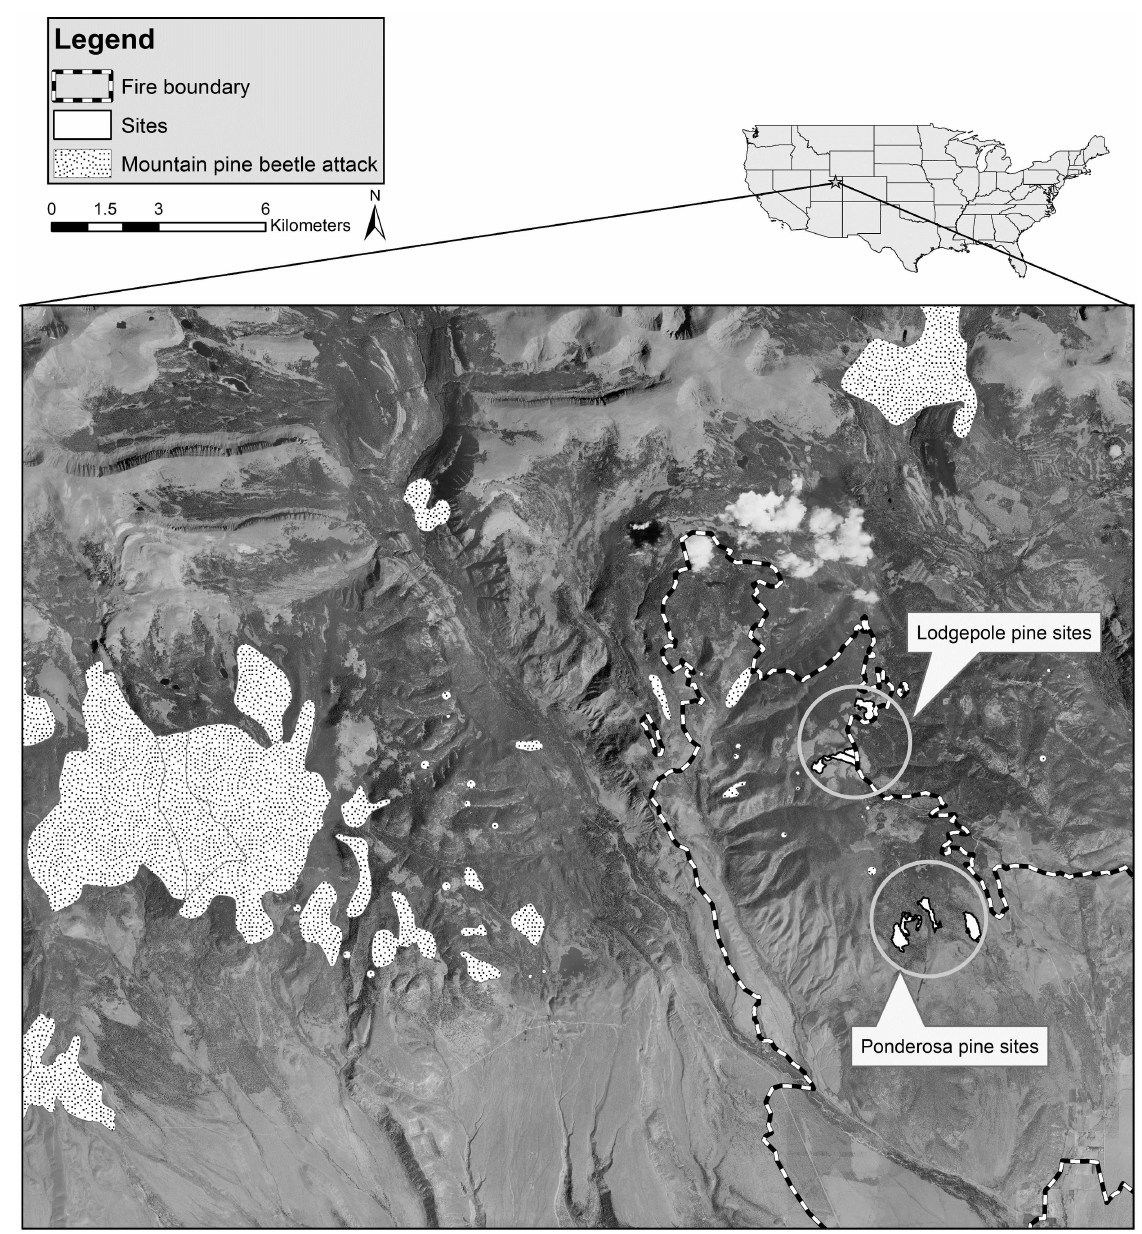
Fig 1. Aerial photograph showing locations of lodgepole and ponderosa pine sites in relation to the Neola North wildfire boundary, and nearest reported mountain pine beetle activity. All sites were affected by the 2007 NeolaNorth fire in northeastern